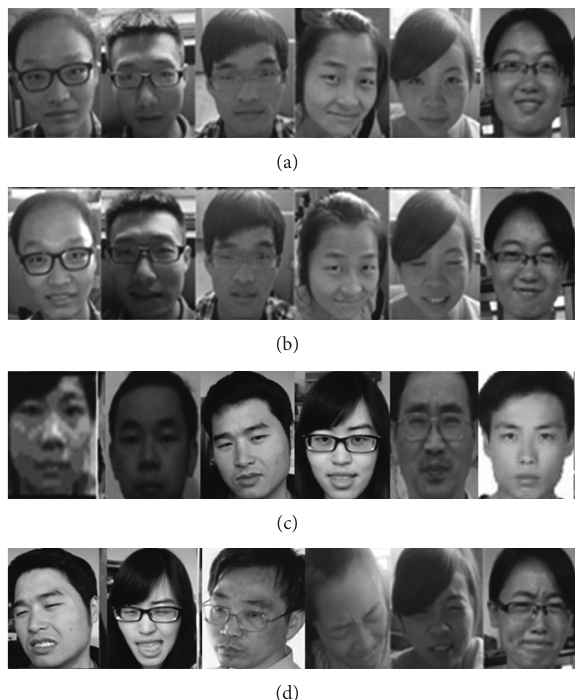
Figure 4: Examples of recognizing pain expression from facial videos. (a) No pain, (b) slight pain, (c) moderate pain, and (d) severe pain.